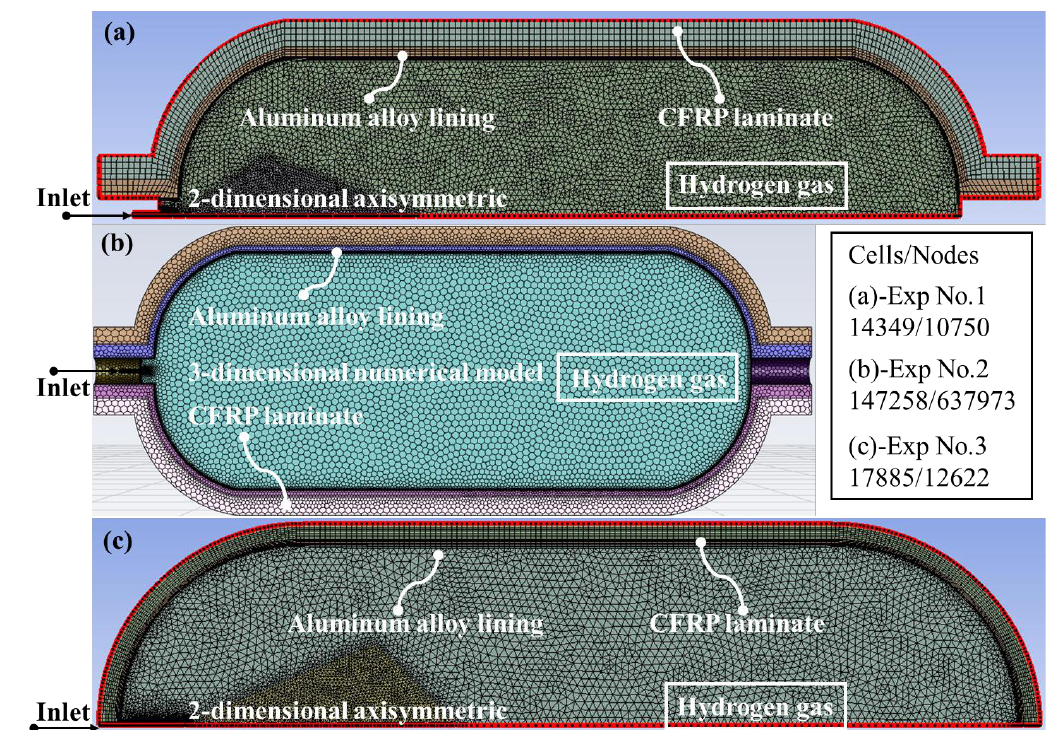
Figure 3. Computational grids of experiment No. 1 ( a ), experiment No. 2 ( b ), and experiment No. 3 ( c ).